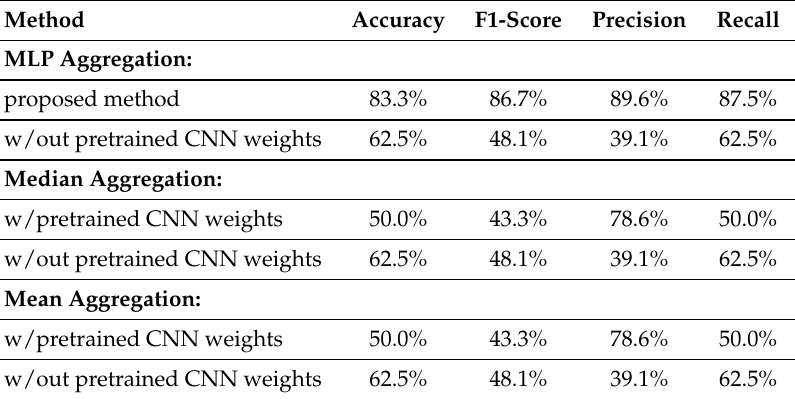
Table 3. Results on the HER2SC test set.